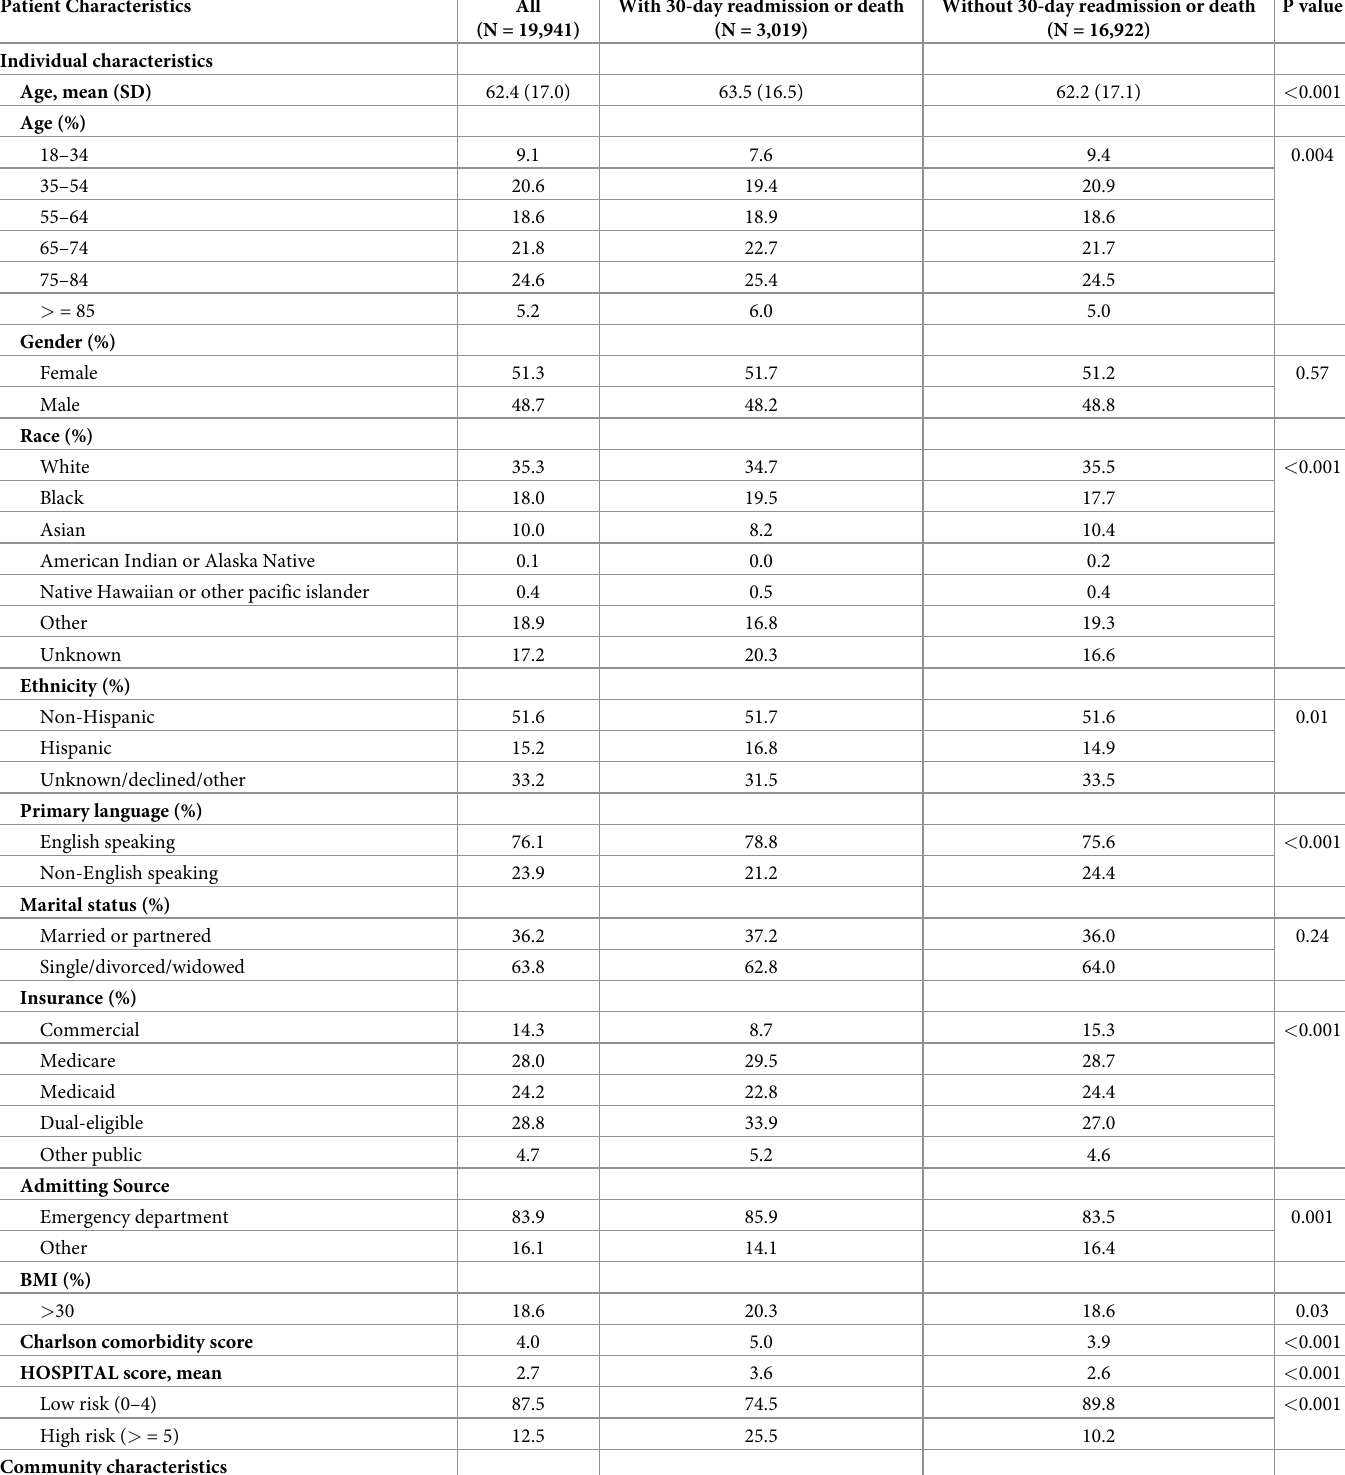
Table 2. Patient characteristics, by readmission or death